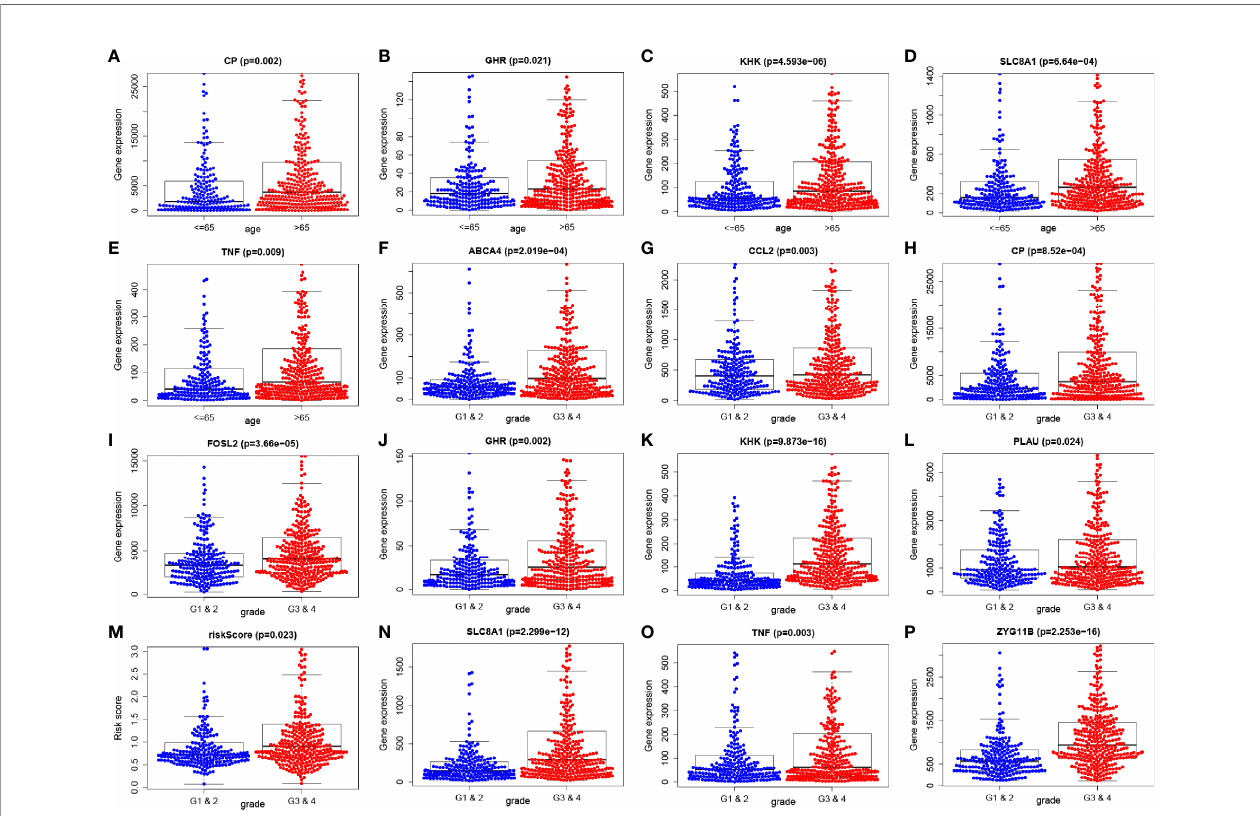
FIGURE 3 | Clinical correlation analysis of 13 genes was carried out and assessed; the results showed that each gene has no correlation with clinical single factors (A – P)